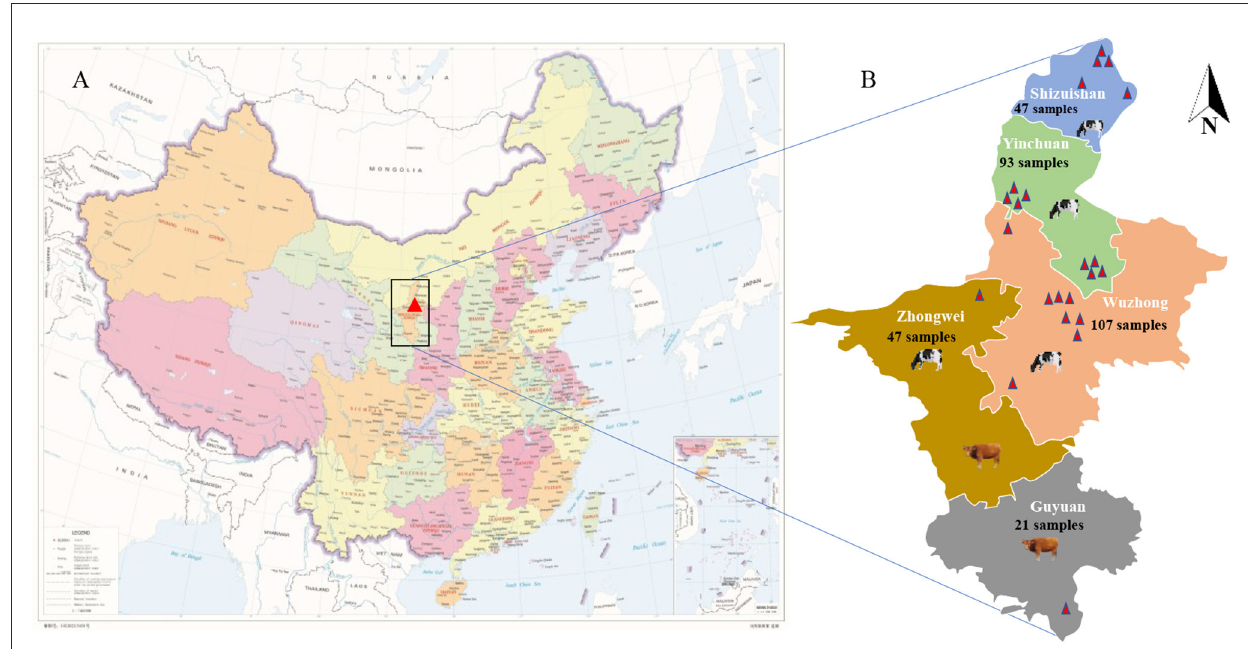
FIGURE1 Cattle farm location and sampling information. (A) The geographical location of Ningxia Hui Autonomous Region (red marked as Ningxia Hui Autonomous Region, red star marked as Beijing, the capital of China). (B) The geographical location of the cattle farm and the total number of samples collected in each city (different colors represent different